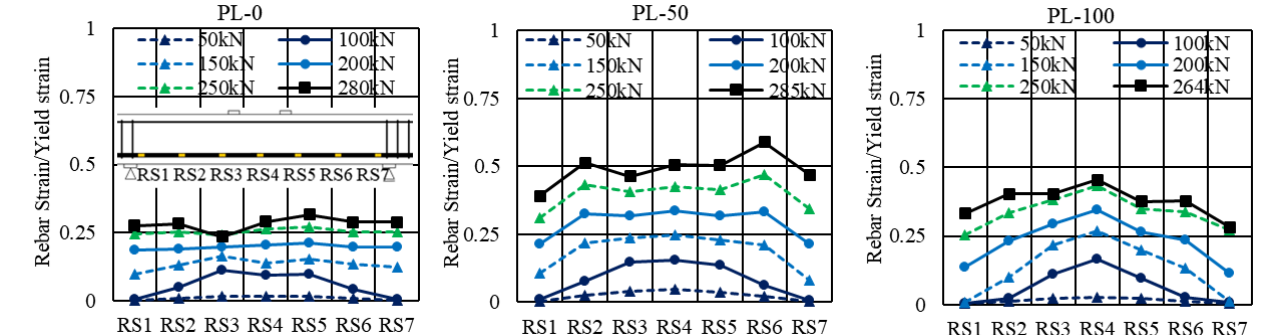
Figure 5. Main rebar strain distribution (PL series).